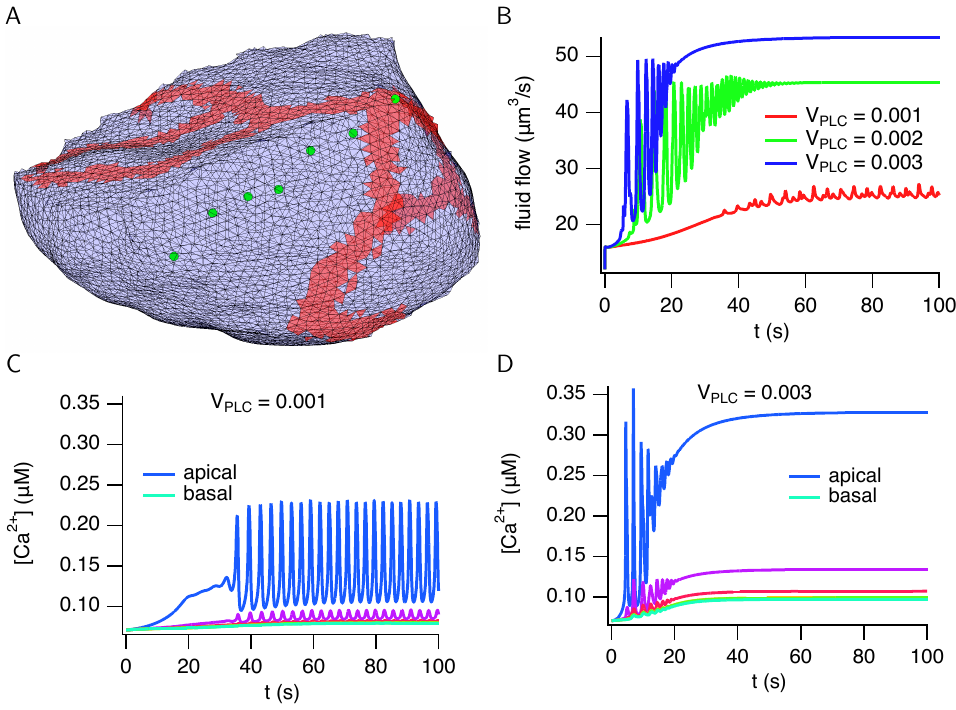
Figure 8. Calcium responses and fluid flow in a cell (cell 1) reconstructed from anatomical data. ( A ): the cell membrane, showing the triangles used in the finite element mesh. Red triangles are apical membrane and blue triangles are basolateral membrane. The green circles show the places for which the Ca 2 + responses are plotted in panels ( C , D ). ( B ): total fluid flow plotted over time for three different stimulation levels. ( C , D ): Ca 2 + responses from six different positions in the cell, denoted by the green circles in ( panel A